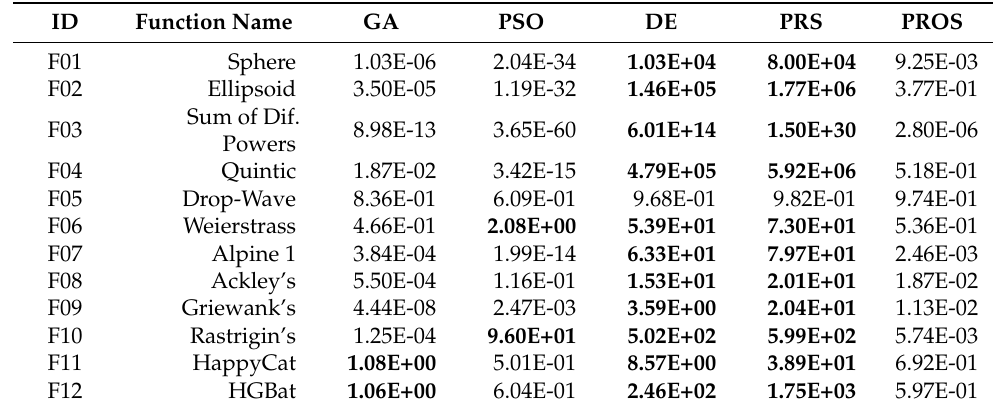
Table 8. Best results * for all 5 optimizers and all 12 objective functions, for 50 dimensions ( D = 50, averages of 10 runs). The target (optimum) value is zero in all cases considered.